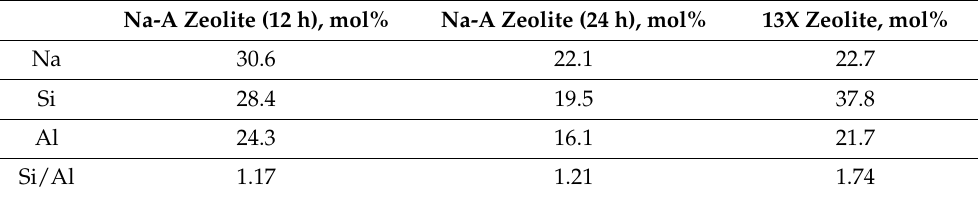
Table 1. Semi-quantitative analysis of selected components of produced zeolites.